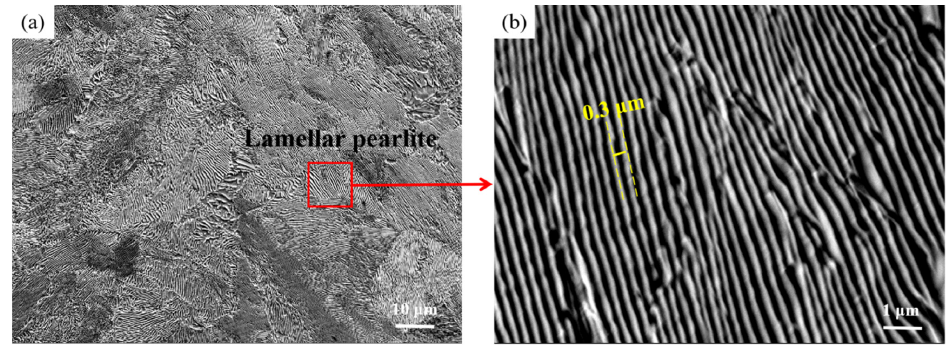
Figure 3. ( a ) Metallographic structure of BM, ( b ) magnified interlamellar spacing of pearlite.